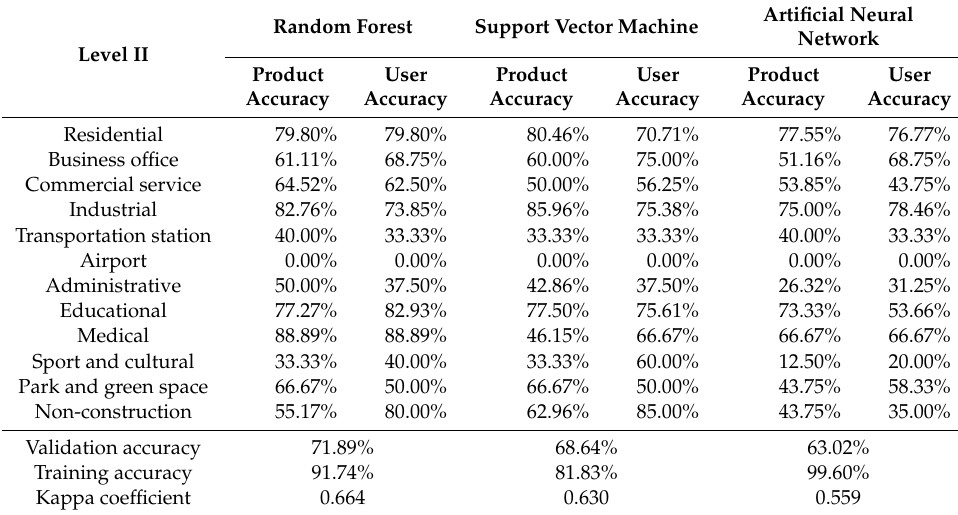
Table 4. Accuracy comparison of the Level II land-use